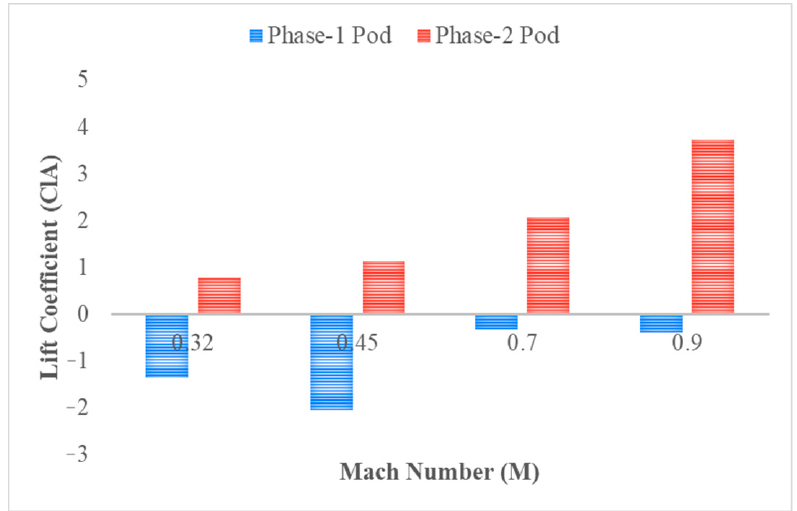
Figure 9. Lift coefficients for the pod models.